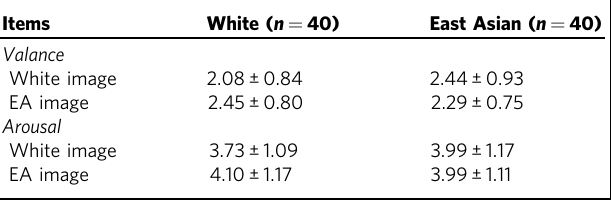
Table 2 Descriptive data of the valence and arousal of experimental materials (mean and standard